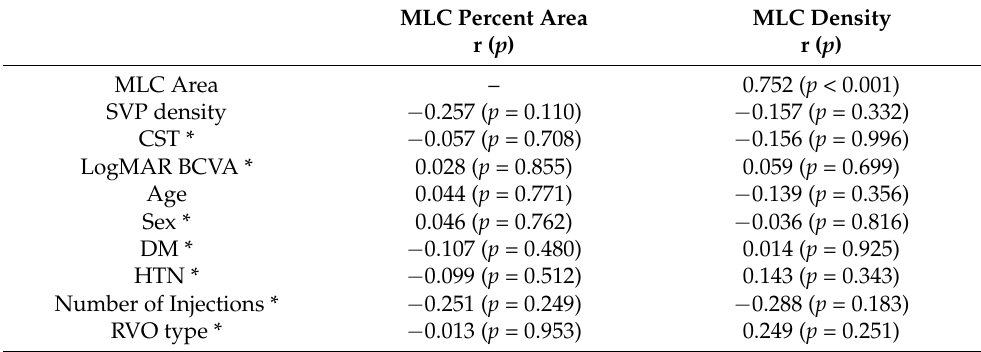
Table 2. Univariate correlation analysis between MLC and patient parameters for all eyes.